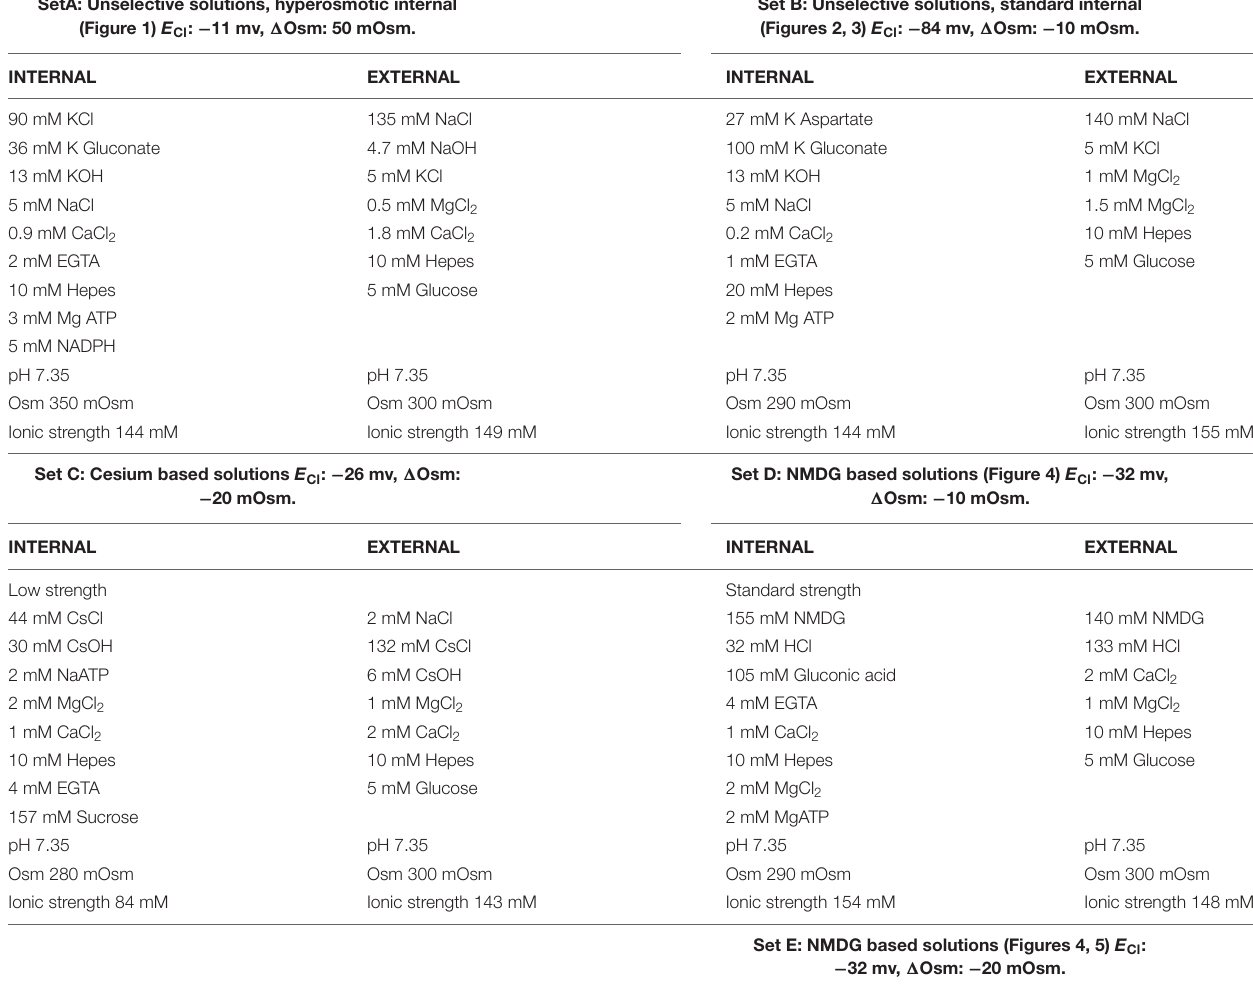
TABLE 1 | Intracellular and extracellular solutions for patch-clamp recordings SetA: Unselective solutions, hyperosmotic internal (Figure 1) E Cl : − 11 mv, (cid:49) Osm: 50